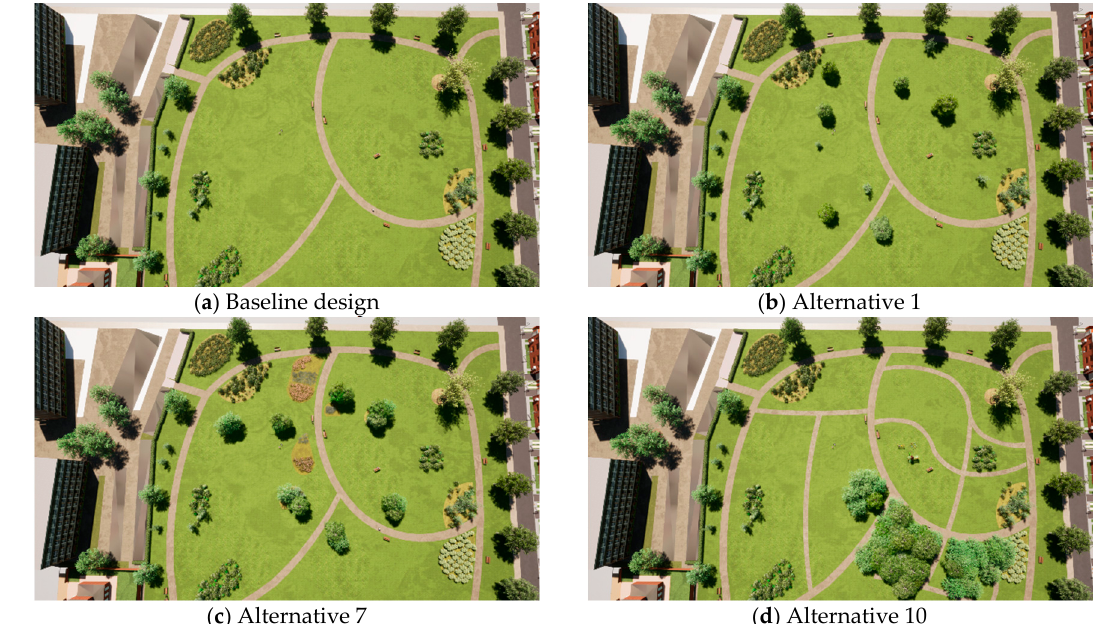
Figure 2. Top views of base level and alternatives; ( a ) Base level; ( b ) Alternative 1 showing few trees spread; ( c ) Alternative 7 showing some trees placed in multiple clusters and diverse flowerbeds; ( d ) Alternative 10 showing many trees placed in one cluster and side paths.